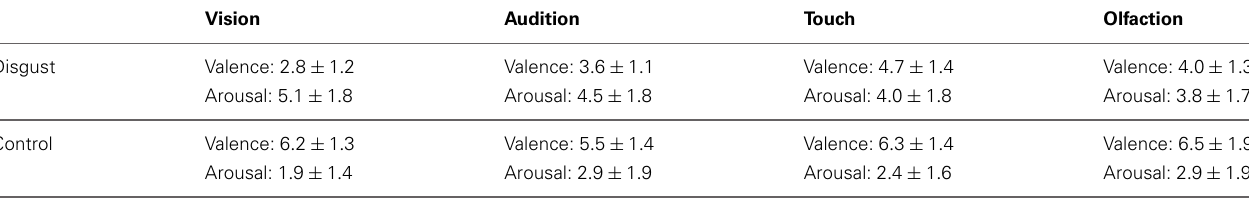
Table 2 | Ratings of hedonic valence and arousal of the disgusting and control stimuli applied through different senses ( N = 119).